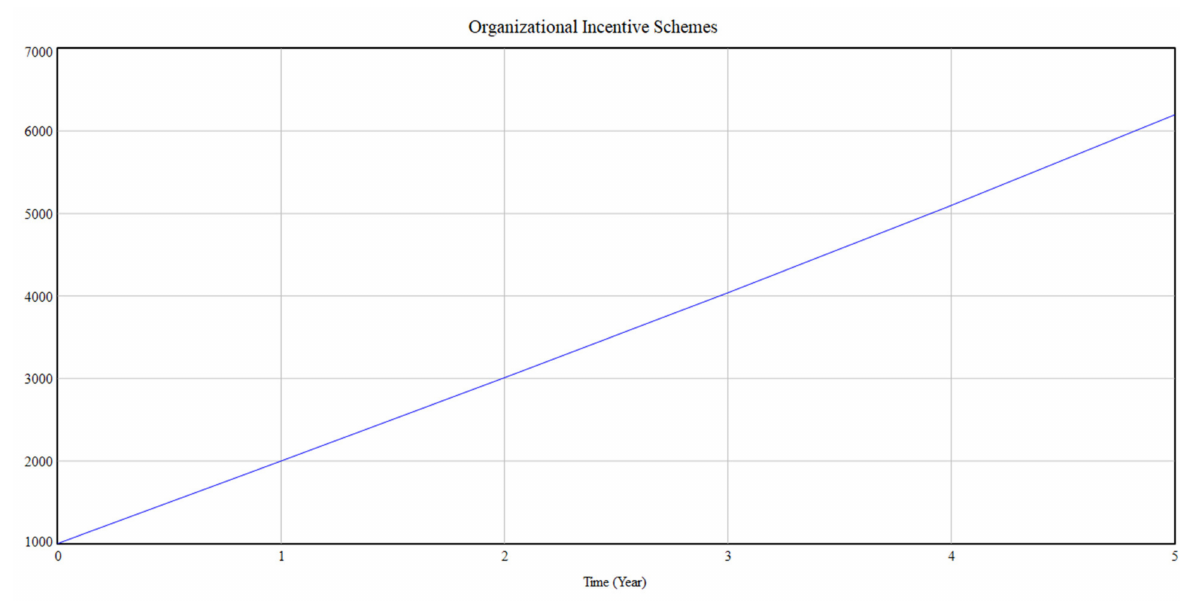
Figure 13. Simulation graph for Organizational Incentive Schemes.